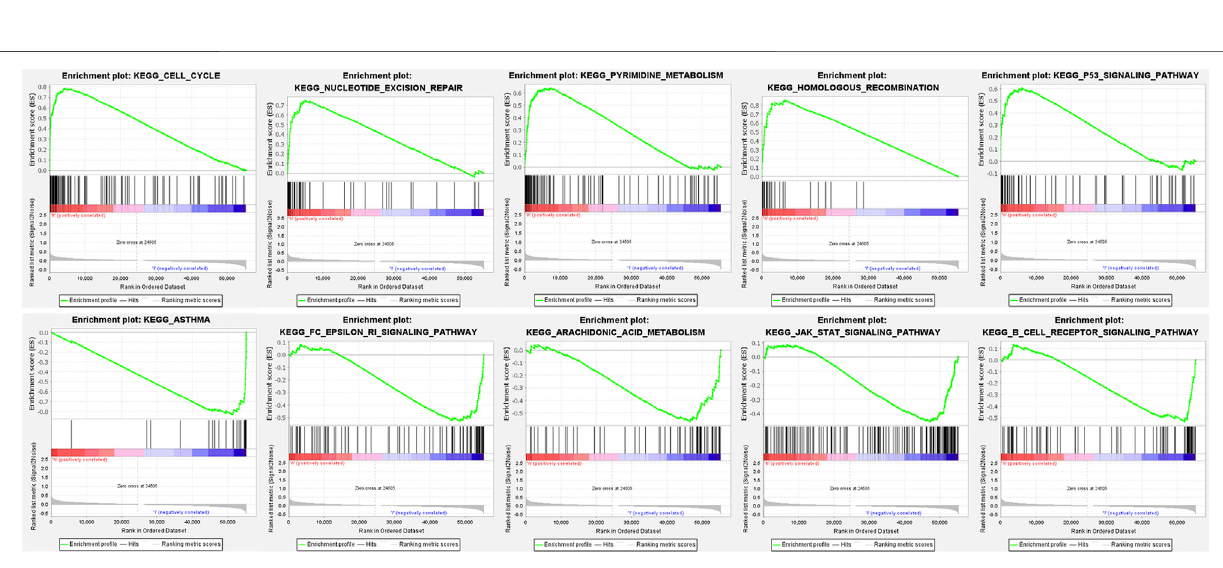
Frontiers in Genetics |